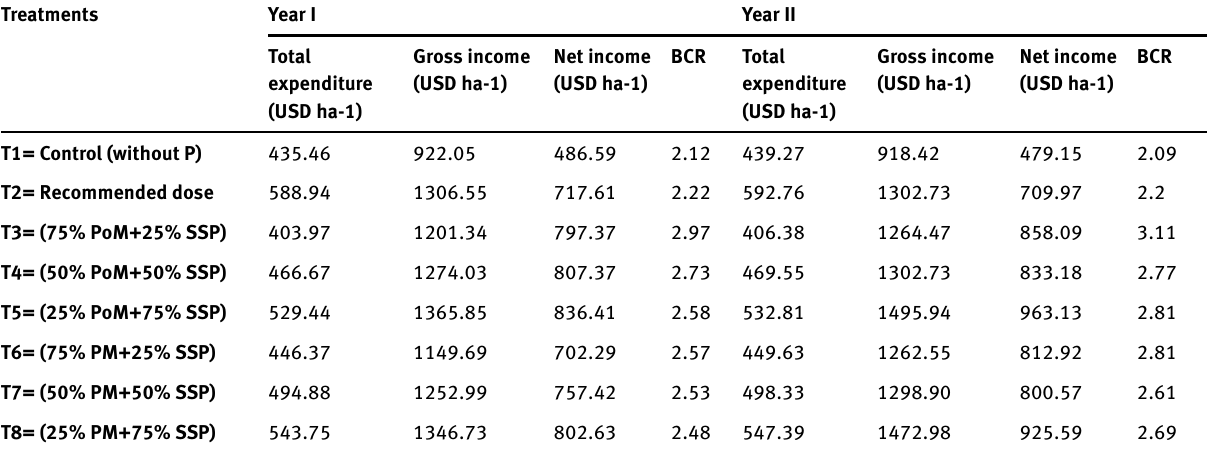
Table 6: Effects of different sources of phosphorous on net income and benefit cost ratio (BCR) of hybrid maize during 2008 and 2009